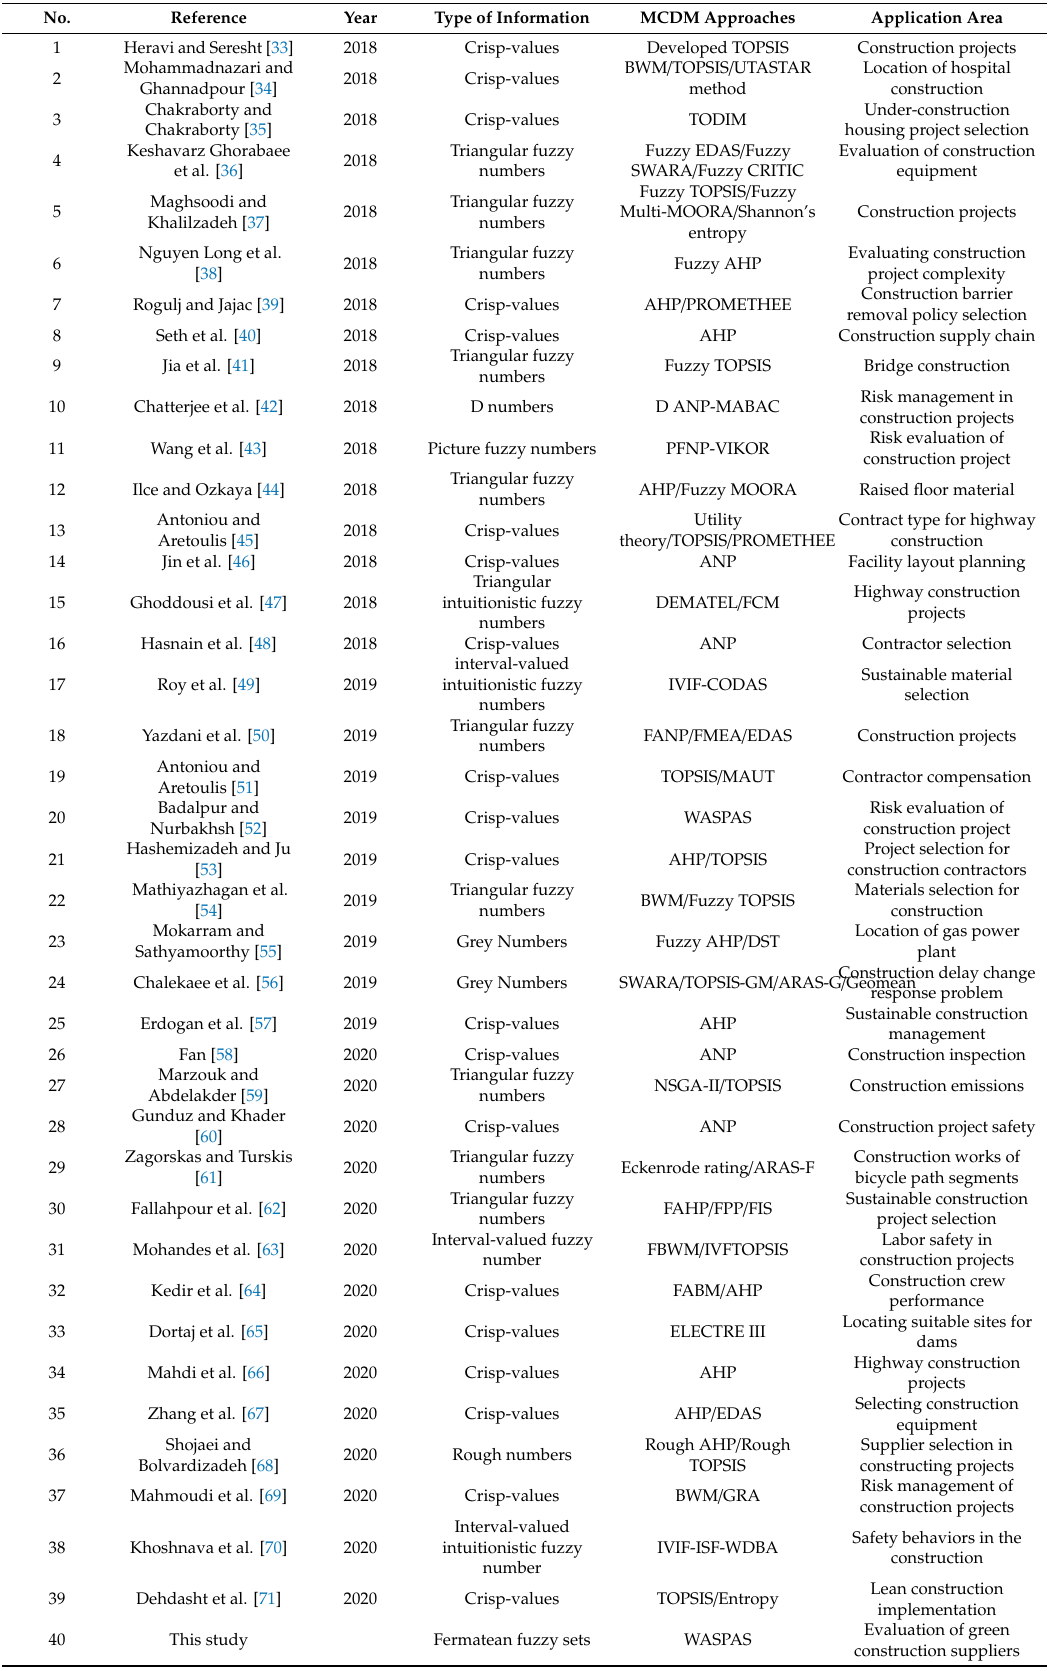
Table 1. Some important studies on MCDM applications in construction